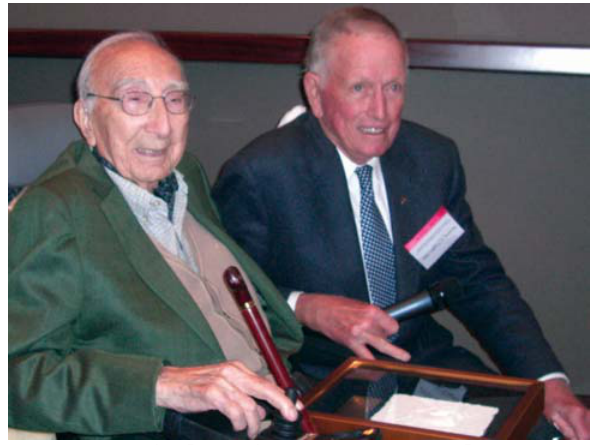
Fig. 1 – Dr. Michael De Bakey e o Dr. Denton